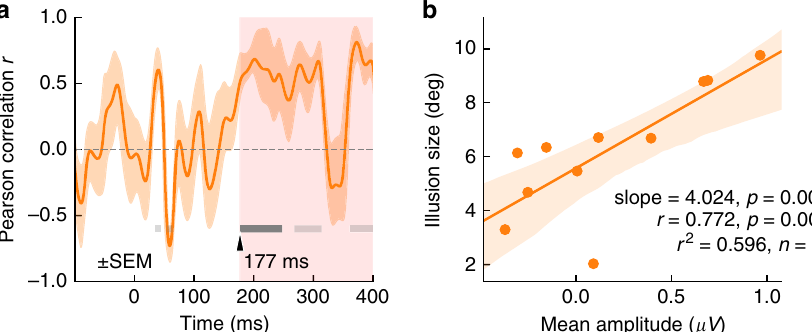
Fig. 6 Inter-subject correlation analysis. a The Pearson correlation between instantaneous amplitude of the difference wave (contralateral minus ipsilateral) in illusory condition (with background-only condition subtracted) and illusion size was calculated at each time point. Dark gray bars indicate period with signi fi cant correlation ( p < 0.05, cluster-based permutation test). Light gray bars indicate period when the absolute value of correlation was greater than the cluster-de fi ning threshold r = 0.5. b The size of perceptual illusion (6.25 ± 2.35 deg) was well predicted by the mean amplitude, averaged within the shaded interval in ( a ). Source data are provided as a Source Data fi